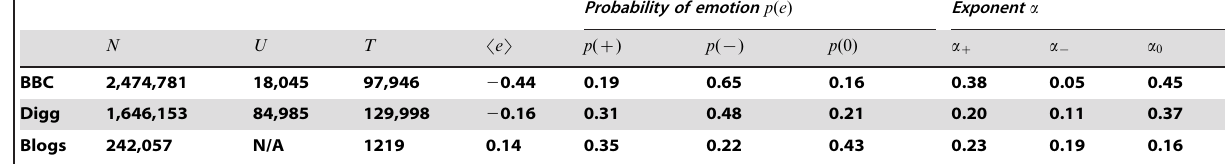
Table 1. Datasets